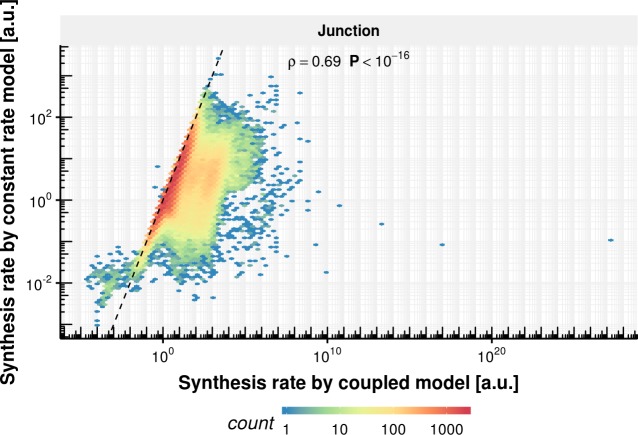
Synthesis rate comparison of coupled and constant rate model.Estimated synthesis rate of the constant splicing rate model (y-axis) vs estimated synthesis rate of the coupled model based on the observed experimental data.